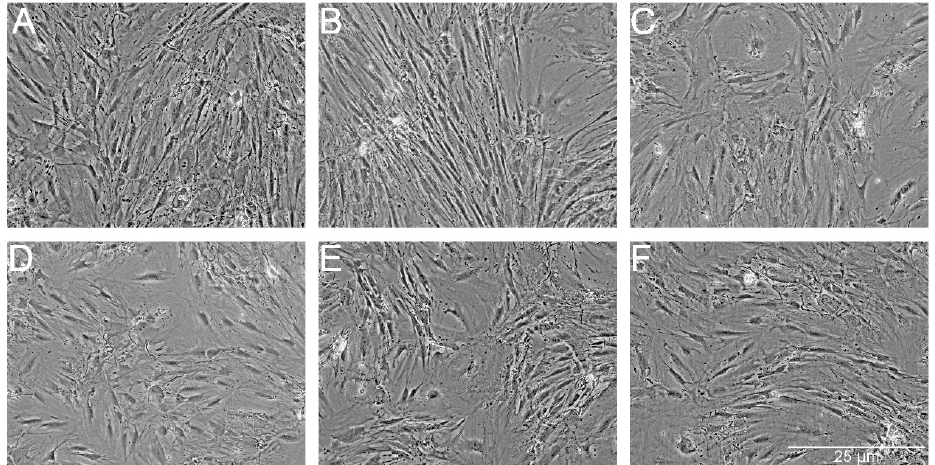
Figure 5. The morphology of the ADSC after exposure to the tested combinations of antibiotics. ADSC were exposed for 14 days to AmB ( B ), AmB-Cu 2+ ( C ), PS ( D ), PS-AmB ( E ) and PS-AmB-Cu 2+ ( F ), and compared to the control cells ( A ).